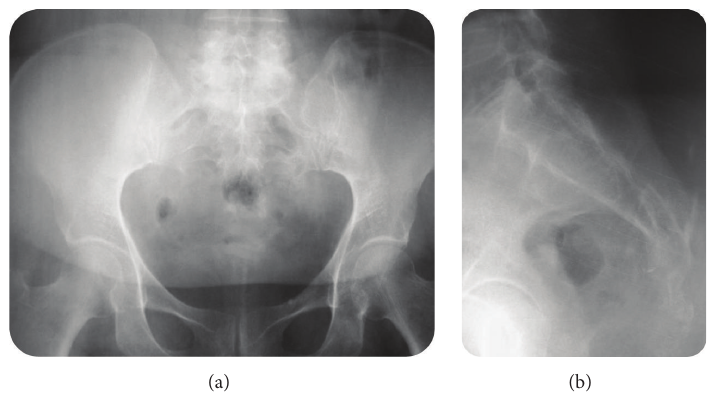
Figure 1: AP and oblique X-rays of pelvis showing fuzziness of the sacrococcygeal region with irregular margins.